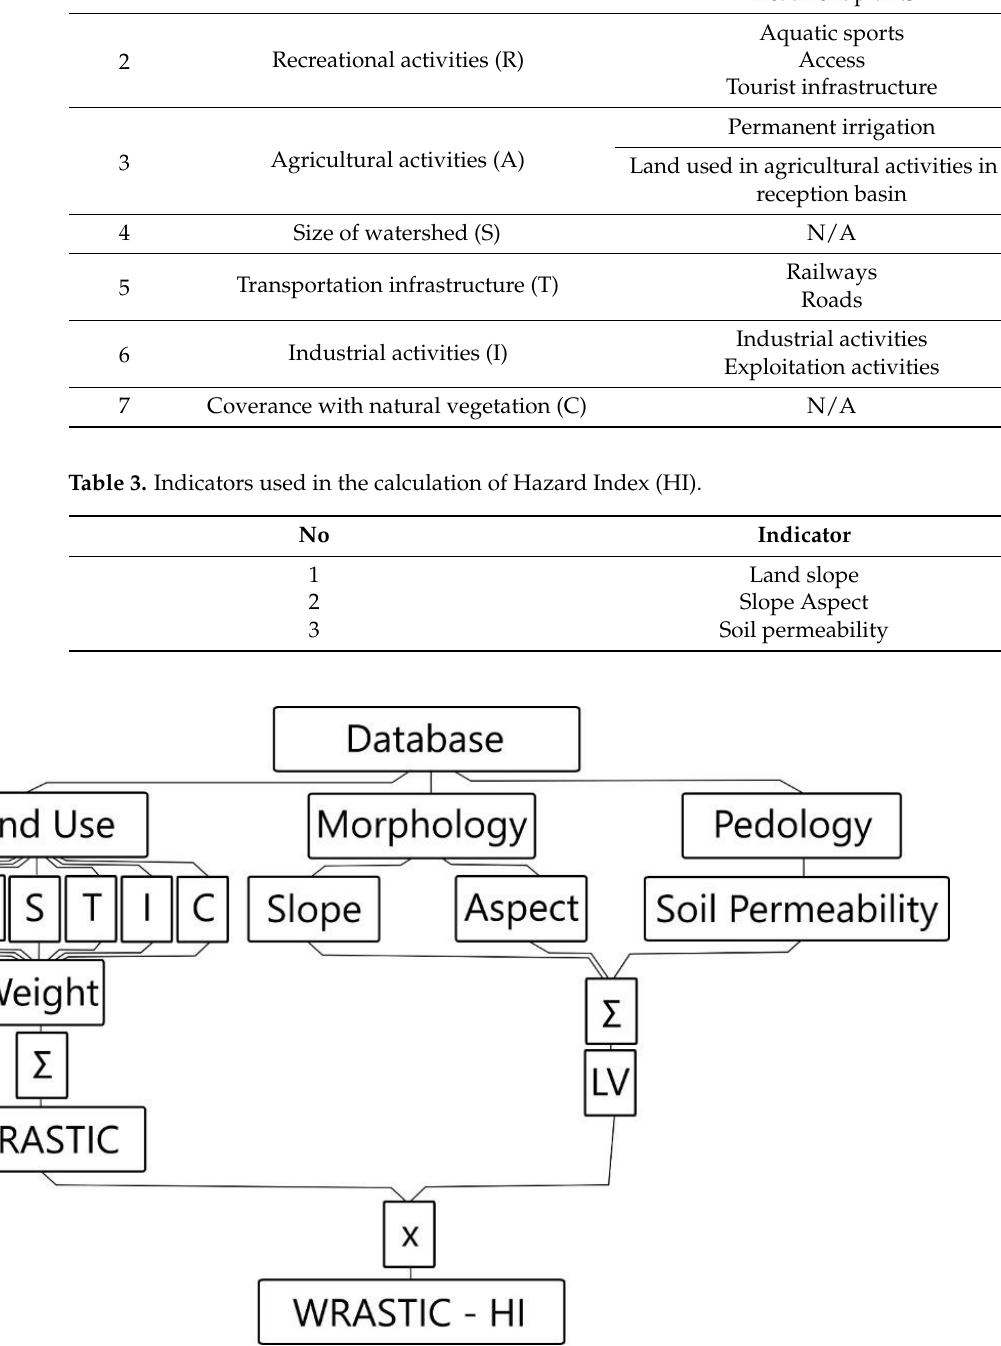
Figure 1. Logical scheme of WRASTIC-HI (Wastewater – Recreation – Agriculture – Size – Transportation – Industry – Cover – Hazard Index).